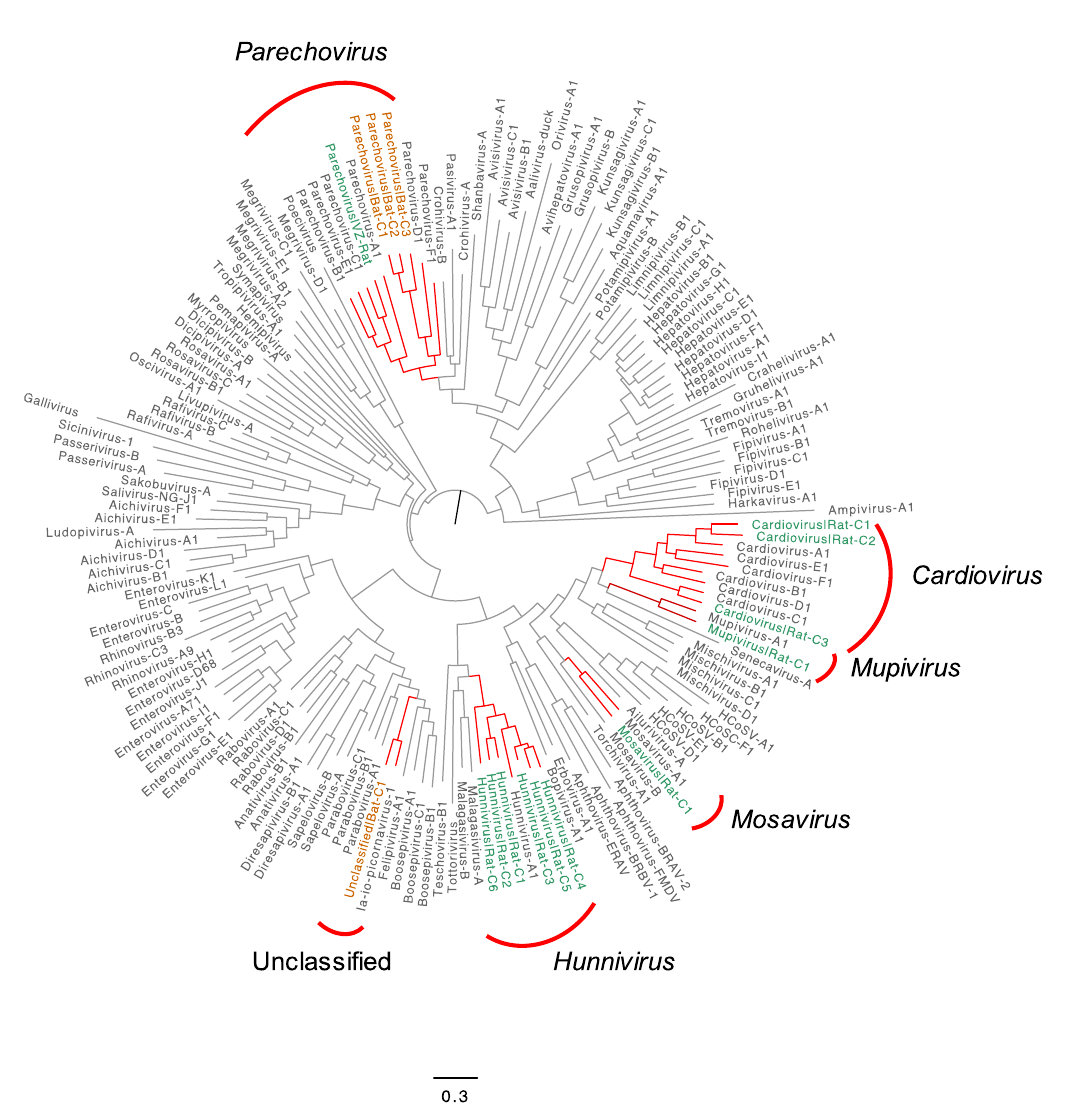
Figure 4. Phylogenetic analyses of putatively novel species or types found in rats and bats and representative members of the family Picornaviridae based on the coding region of P1. The branches of 5 genera and an unclassified picornavirus with novel clusters (labelled with C)/sequences from rats (green in tips) and bats (orange in tips) found in Vietnam are highlighted in red. The trees are constructed using maximum likelihood methods with HKY + G4 + I model and 1000 bootstraps. Scale bar indicates number of nucleotide substitutions per site.